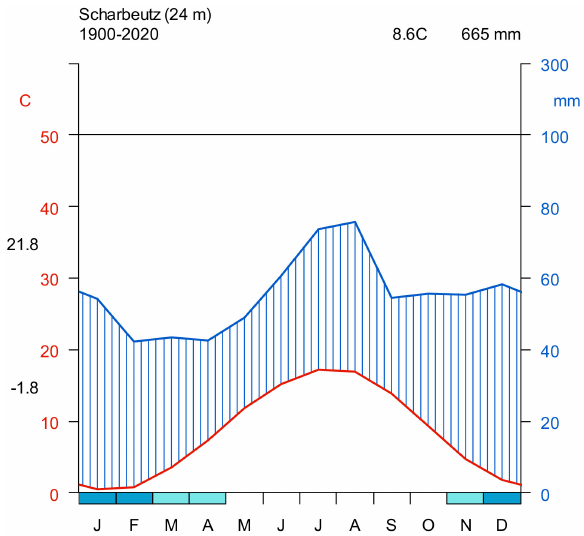
Figure 1. Walter–Lieth climate diagram for Scharbeutz, Schleswig-Holstein. Precipitation and temperature data were measured from 1900 to 2020. The left y -axis shows temperature ( ◦ C), and the right y-axis shows precipitation (mm). The x -axis shows the months. The red curve shows the temperature, and the blue curve shows the